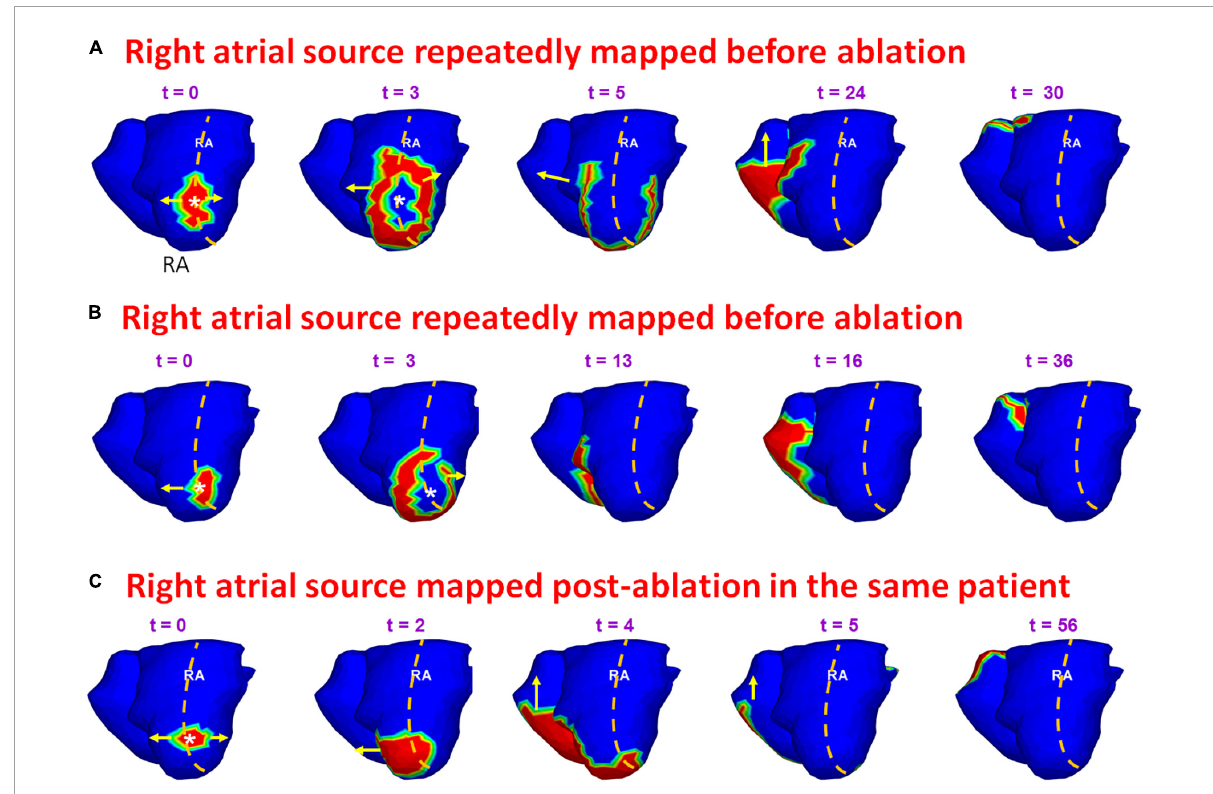
FIGURE13 Persistence of pre-ablation RA source during recurrent AF. Panels (A,B) show time sequence of wavefront activation originating from a source in posterolateral RA near the floor, reconstructed for two different time intervals during pre-ablation ECGI. Panel (C) shows the activation maps reconstructed during post-ablation ECGI. Similar to the pre-ablation activity, a source originates in the posterolateral right atrium near the floor. The activation pattern in panel (C) is similar to the pre-ablation wavefront propagation in panels (A,B) . Supplementary Video 9 shows the activation during pre-ablation and recurrent